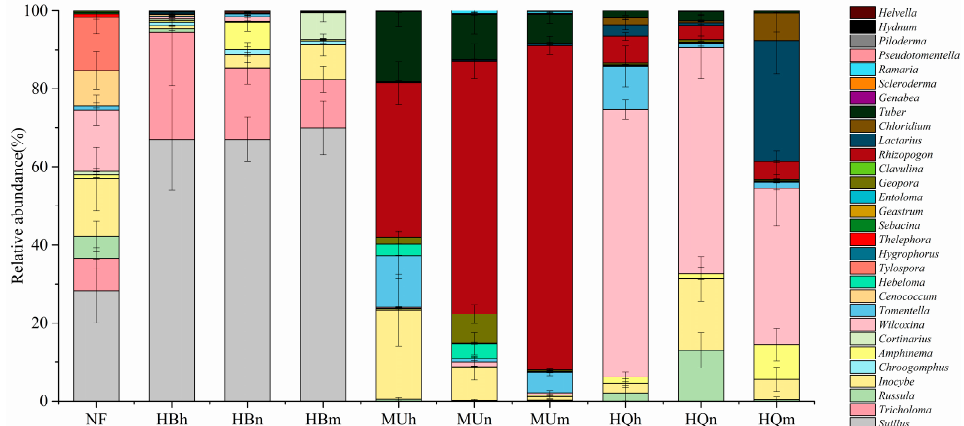
Figure 5. Relative abundances of EM fungal genera in each P. sylvestris stand across three sandy lands. The relative abundances were calculated as an average of 5 replicates in each stand.